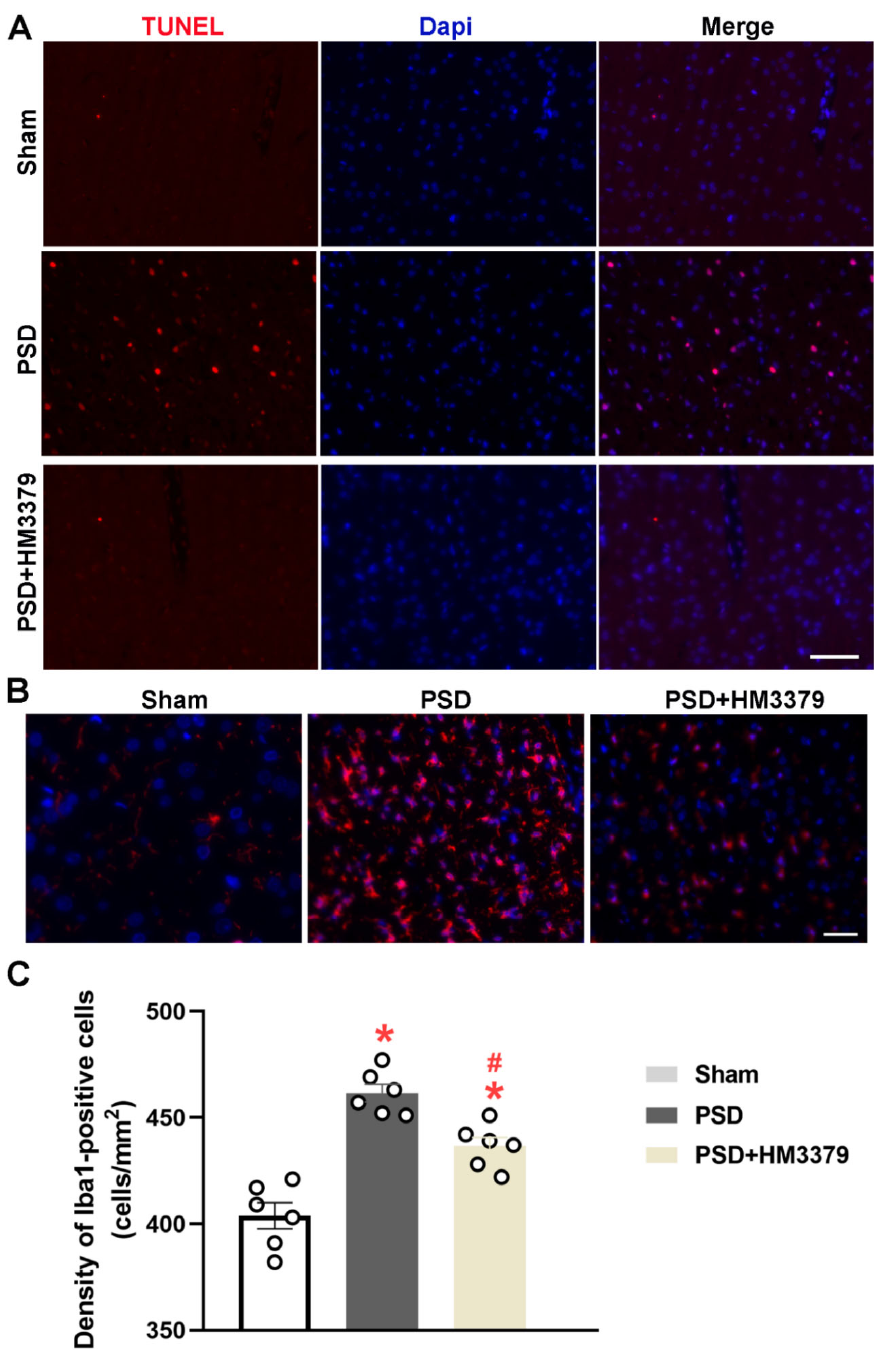
Figure 2. HM3379 attenuated neurocyte apoptosis and inhibited microglial activation in the PSD gerbils. ( A ) TUNEL (red) staining was localized in the nuclei of neurons as shown in the PSD group. Fewer TUNEL-positive cells were observed in the PSD + HM3379 group than the PSD group. N = 3 per group. Scale bars = 100 µ m. ( B ) Representative immunofluorescent staining of the Iba-1-positive cells in the cortex of PSD gerbils. ( C ) The density of the Iba-1-positive cells was quantified. Data are expressed as mean ± SEM. * indicates p < 0.05 vs. sham, # indicates p < 0.05 vs. PSD. N = 6 per group. Scale bar = 100 µ m. PSD, post-stroke depression. TUNEL, transferase dUTP nick end